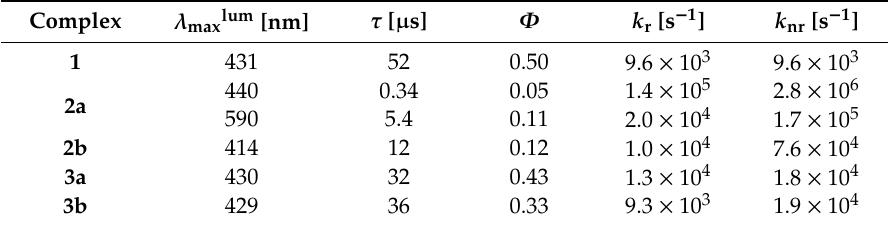
Table 3. Photophysical parameters for gold complexes as crystals at room temperature. Complex